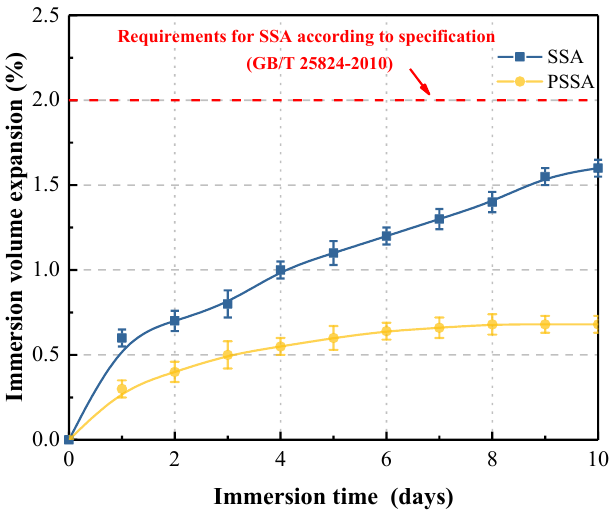
Figure 7. Swelling test results of SSA and PSSA.